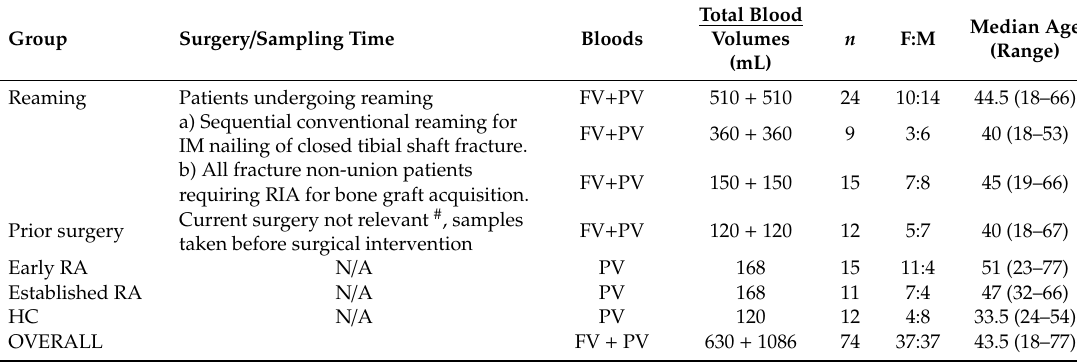
Table 1. Blood collection information and total blood volumes used for mesenchymal stem cells (MSC)